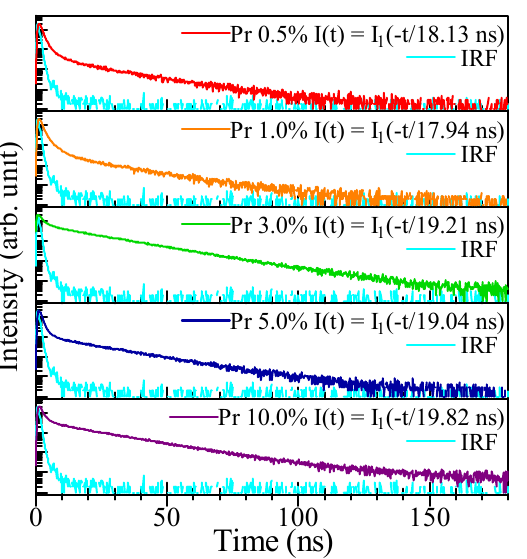
Figure 5. PL decay time profile of Pr-doped LaPS samples. The excitation and emission wavelengths are 280 and 330 nm, respectively.